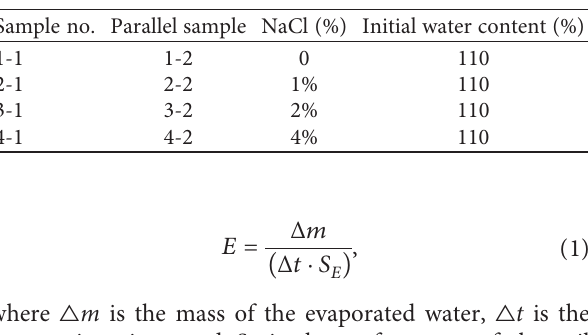
Table 2: Test design of the